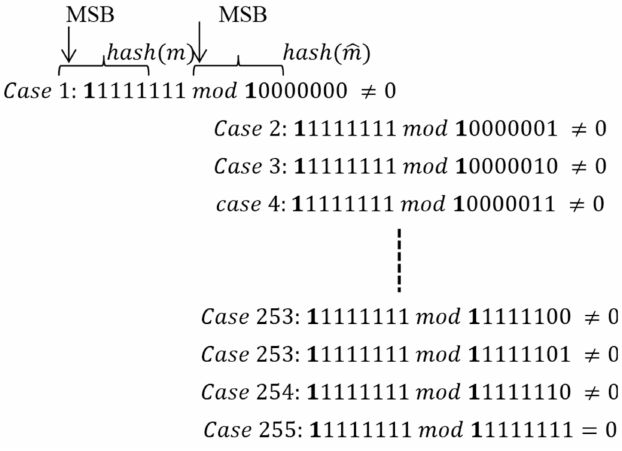
Figure 2. Proof that 255 mod ( 128 to 254 ) is always